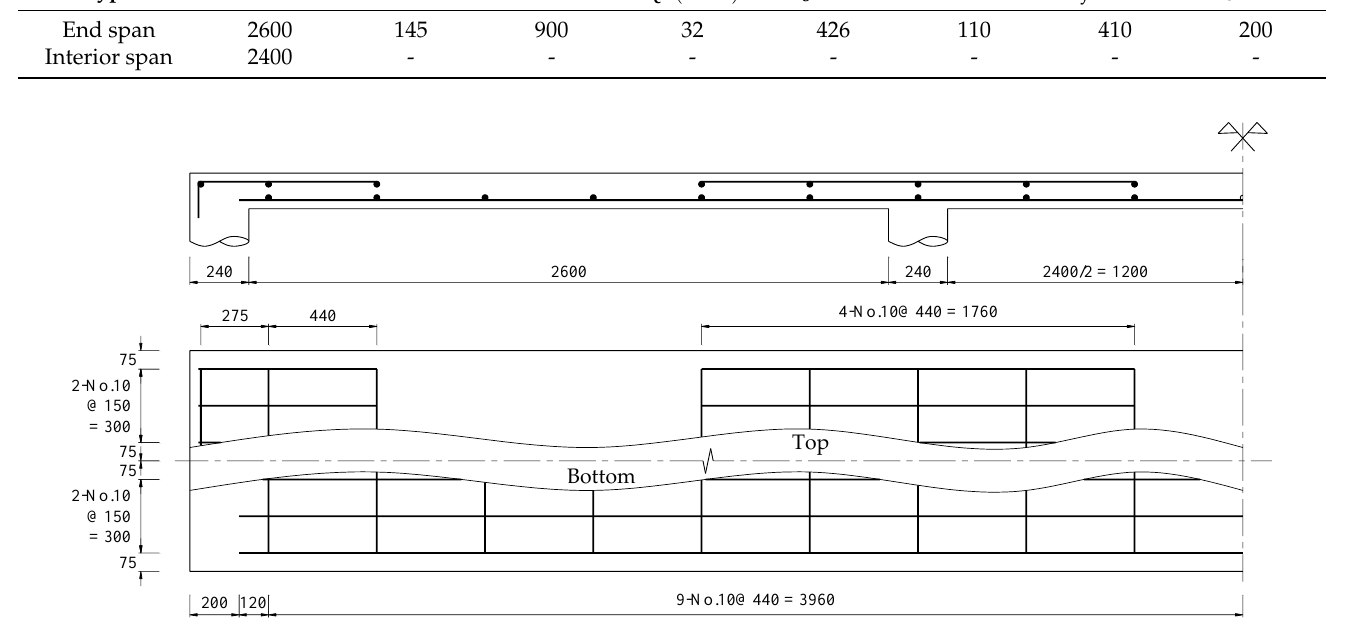
Figure 6. The reference slab ’ s reinforcement detail and dimensions (in mm). Table 4. The initial CFRP thickness and retrofit system ’ s material properties.